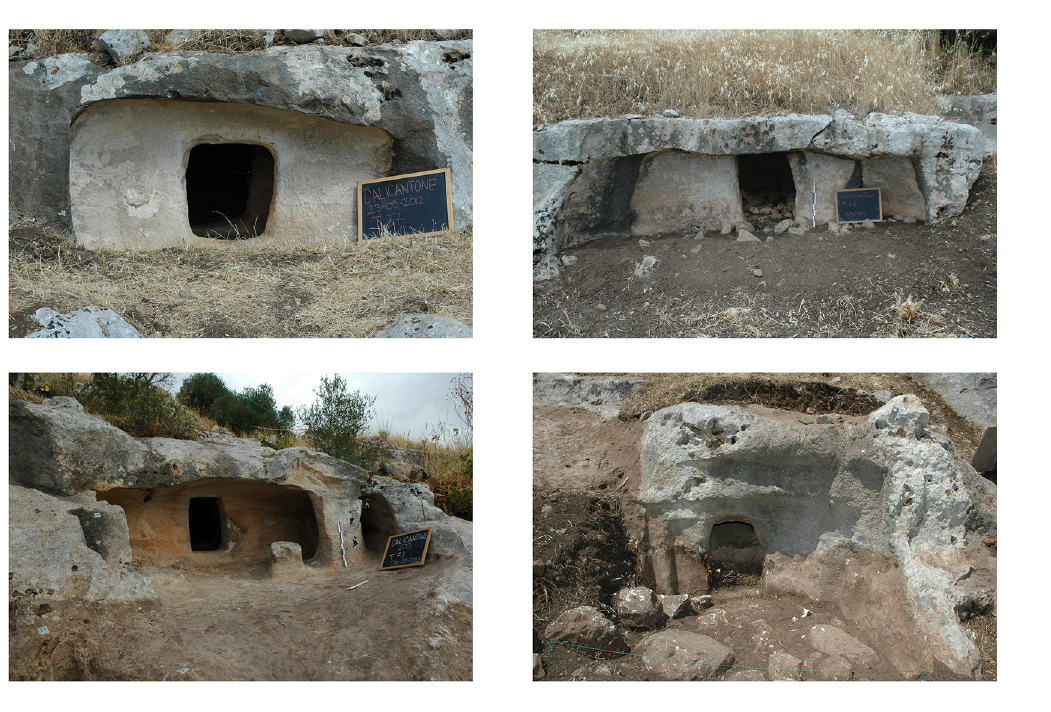
Figure 15. Courtyards of the tombs 37(a), 26(b), 73(c),